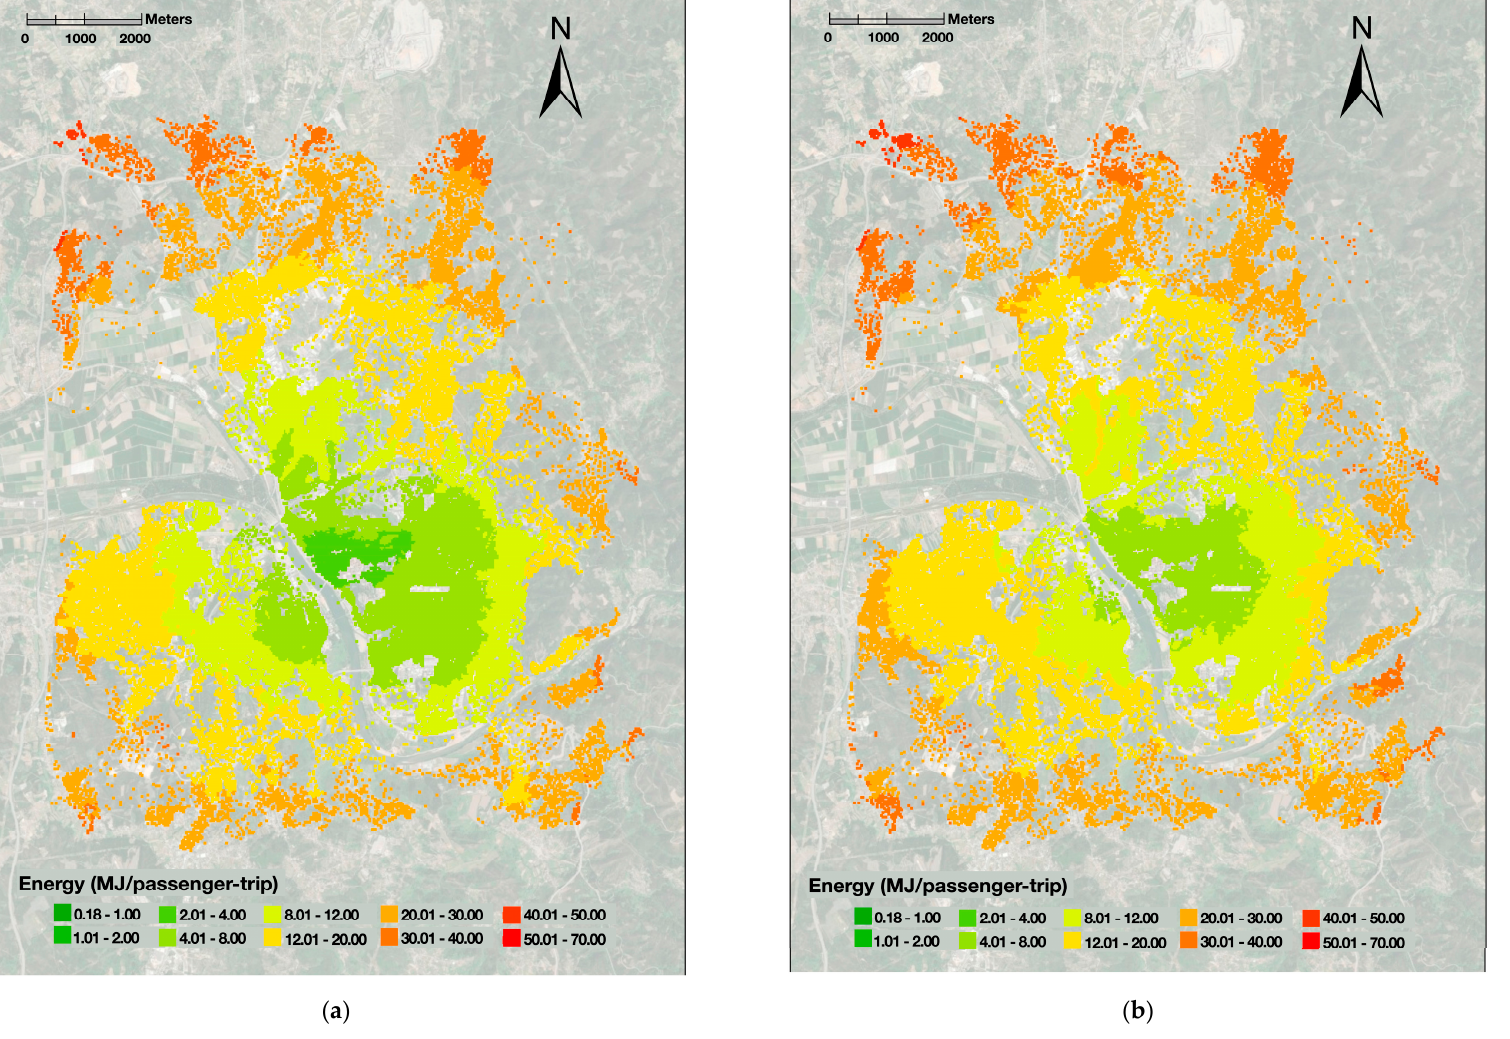
Figure 4. ( a ) Fossil energy spending for full cycling: facilities and jobs; ( b ) Fossil energy spending for no cycling: facilities and jobs.